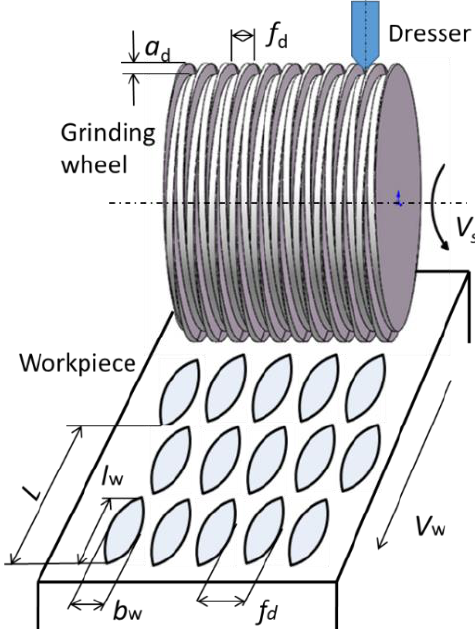
Figure 1. Microstructural surface creation by grinding.